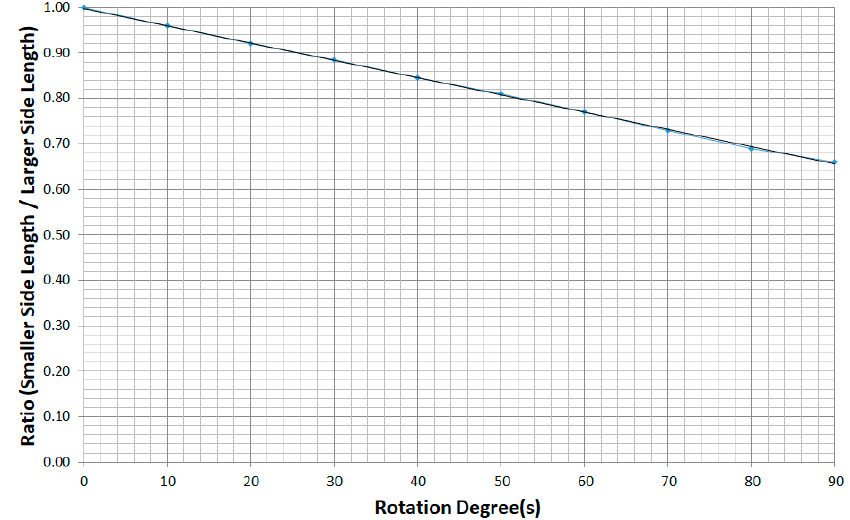
Figure 17. Relationship between the image sides’ ratios and the camera’s degree of rotation.